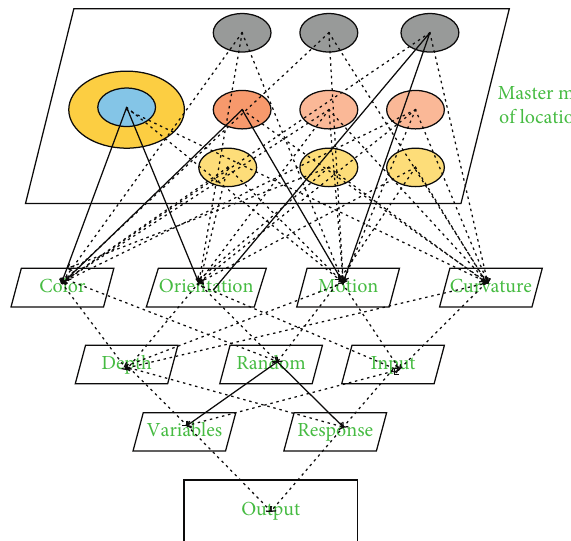
Figure 1: Theoretical model of feature